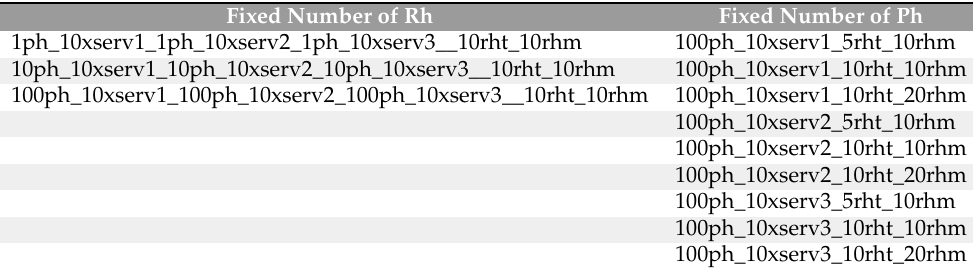
Fixed Number of